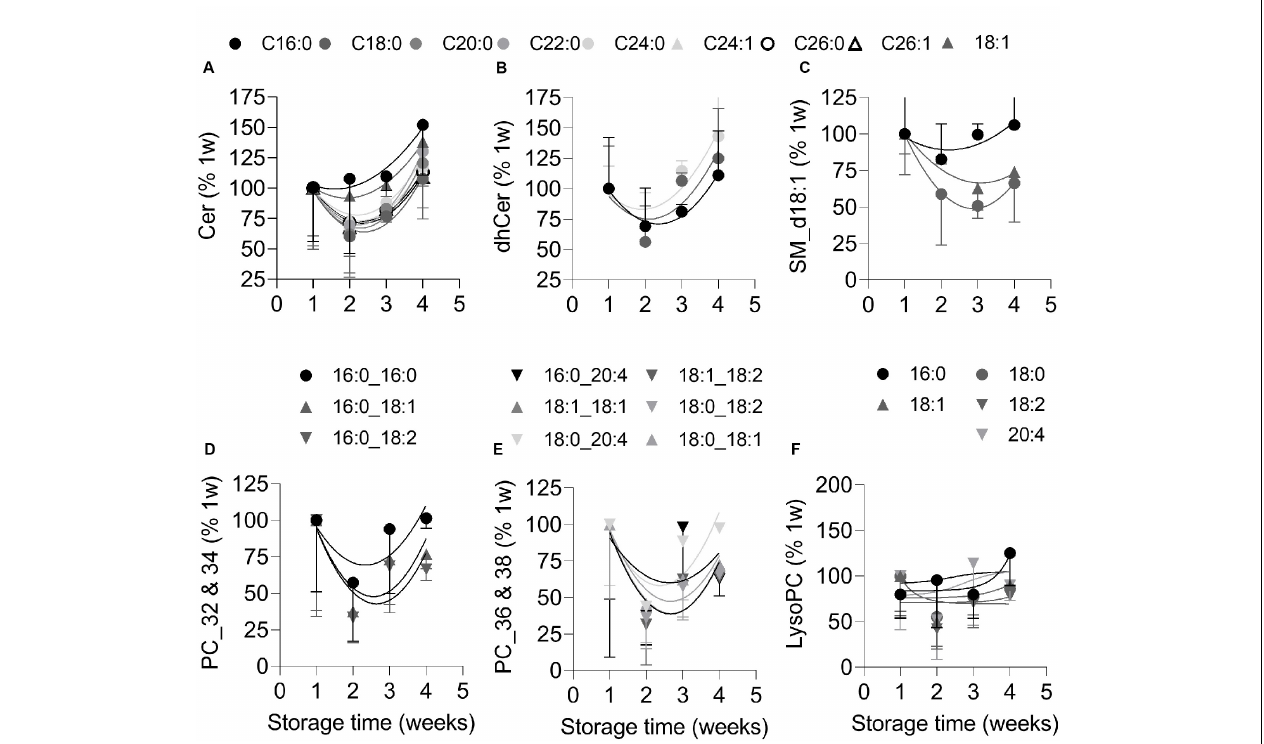
FIGURE 6 | RBC-derived EVs are enriched in ceramide and dihydroceramide species at the end of storage but nearly depleted in sphingomyelin and phosphatidylcholine species. RBC-released EVs were isolated from total blood EVs by immunopurification and analyzed by LC-MS for their content in: (A,B) ceramide (cer) and dihydroceramide (dhcer) species; (C) SM d18:1 species; and (D–F) phosphatidylcholine (PC; presented in two graphs according to the length of their carbon chains) and lysoPC species. Each curve depicts one lipid species; circle, saturated lipid; triangle, lipid containing at least one MUFA; inverted triangle, lipid containing at least one PUFA; black to light gray and white colors, short to long carbon chains. Notice that most of the SM species (e.g., 16:1) and some PC species (e.g., 16:0_18:0) were at the limit of detection. Representative experiment out of 2. All data were expressed as % of the EVs stored for 1 week and are means ± SD of 4